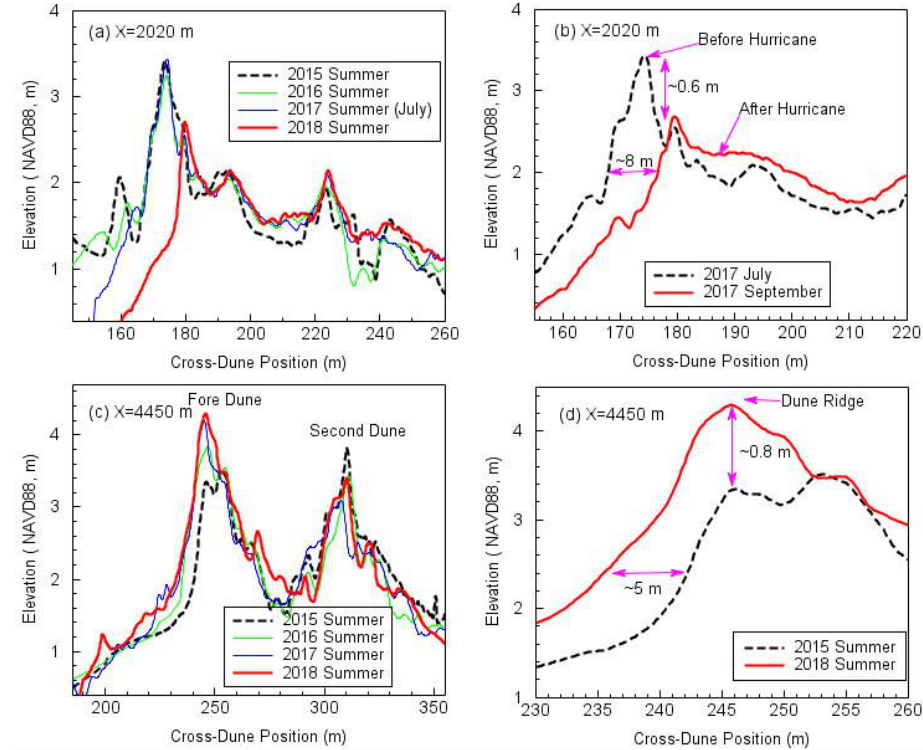
Figure 16. Cross-dune profiles extracted from DEMs (0.3 m by 0.3 m) obtained from rapid TLS surveys in four summers. ( a ) The cross-dune profiles at X = 2020 m; ( b ) the cross-dune profiles depicting significant dune erosions during the 2017 Hurricane Harvey; ( c ) the cross-dune profiles at X = 4450 m; ( d ) the cross-dune profiles depicting dune growth during a three-year period. The locations of the profiles are marked in Figure 15.